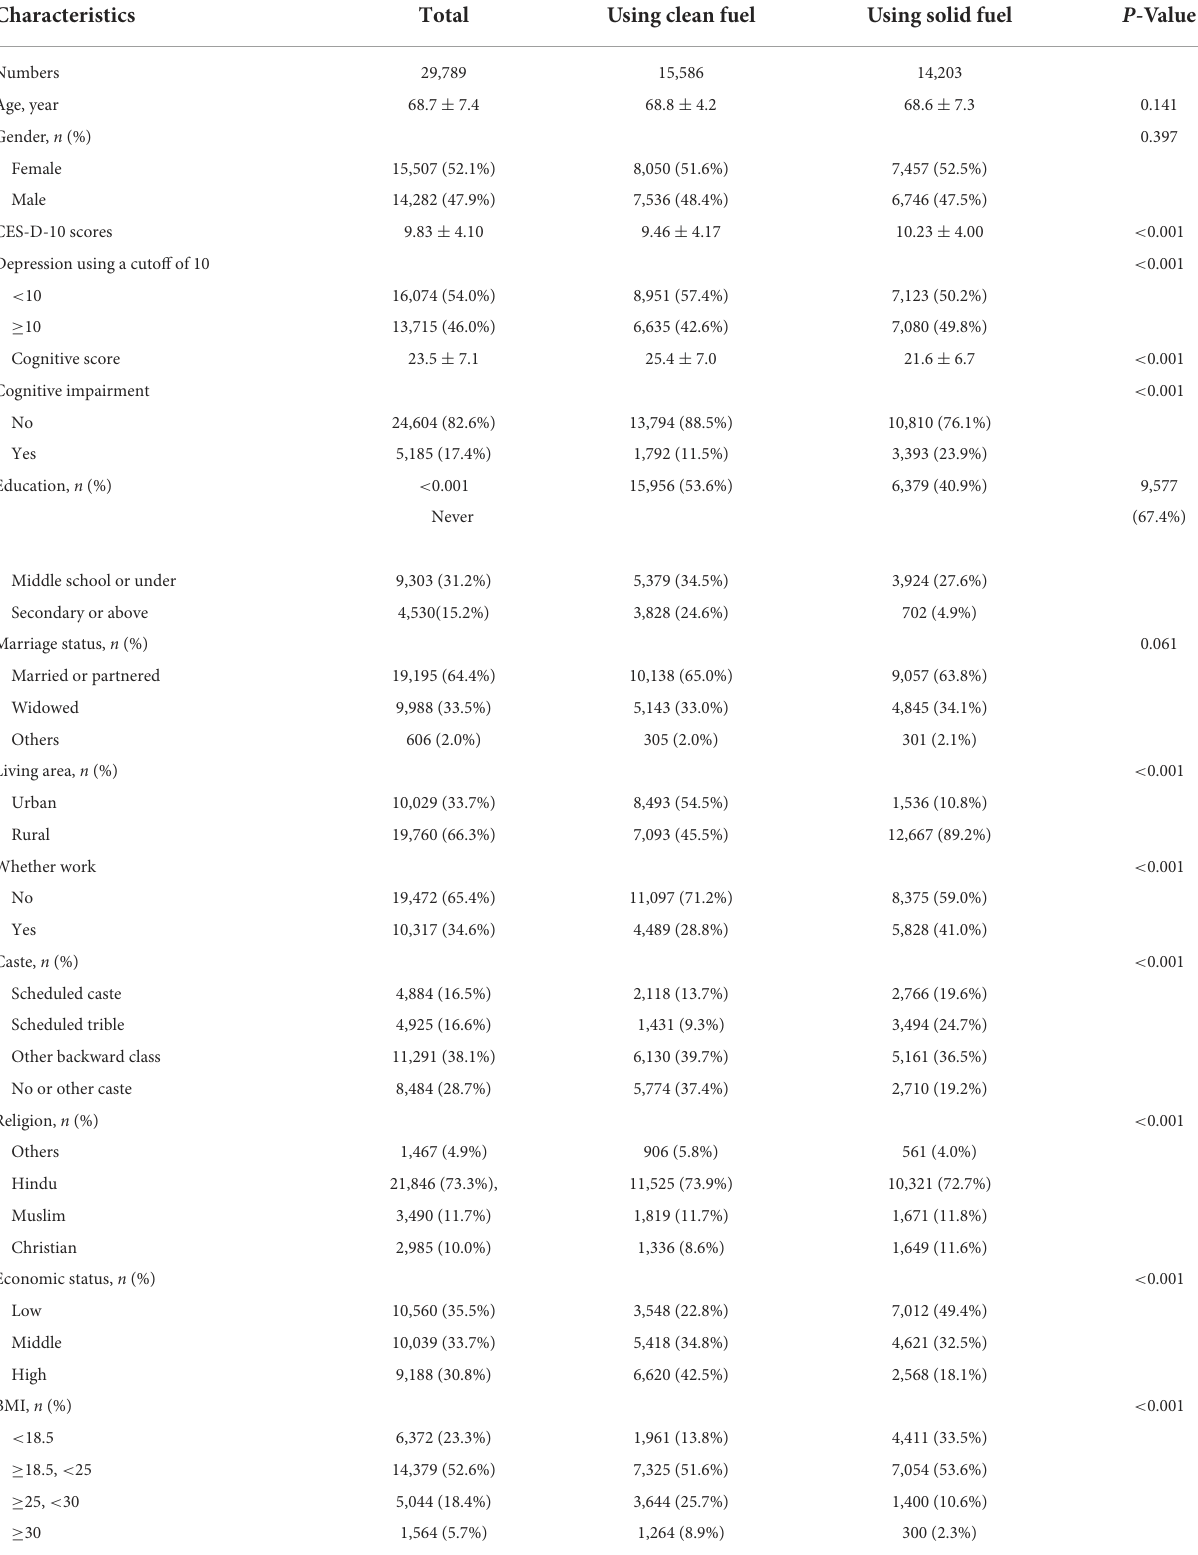
TABLE 1 Characteristics of participants using solid fuel or using clean